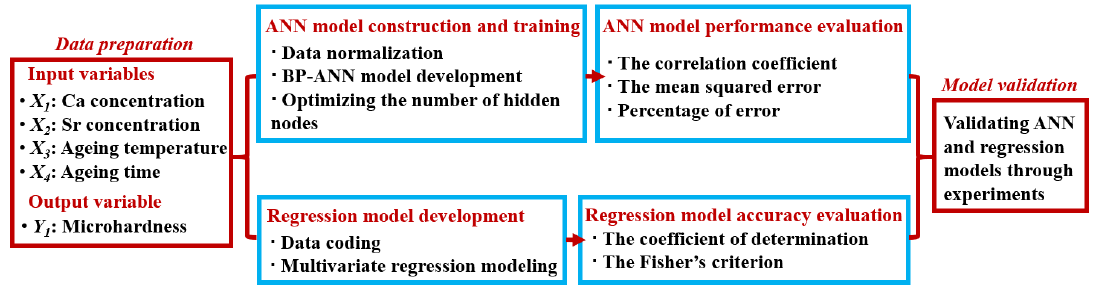
Figure 1. The flow chart of this study.